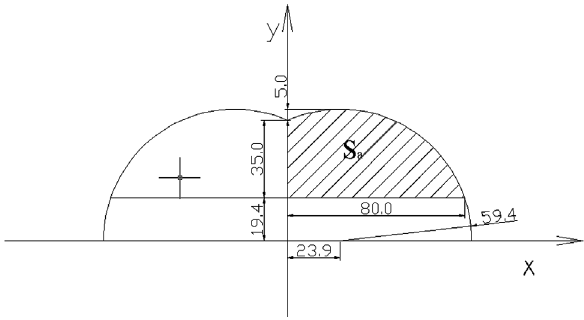
Figure 4 The actual size of cross-section/ μ